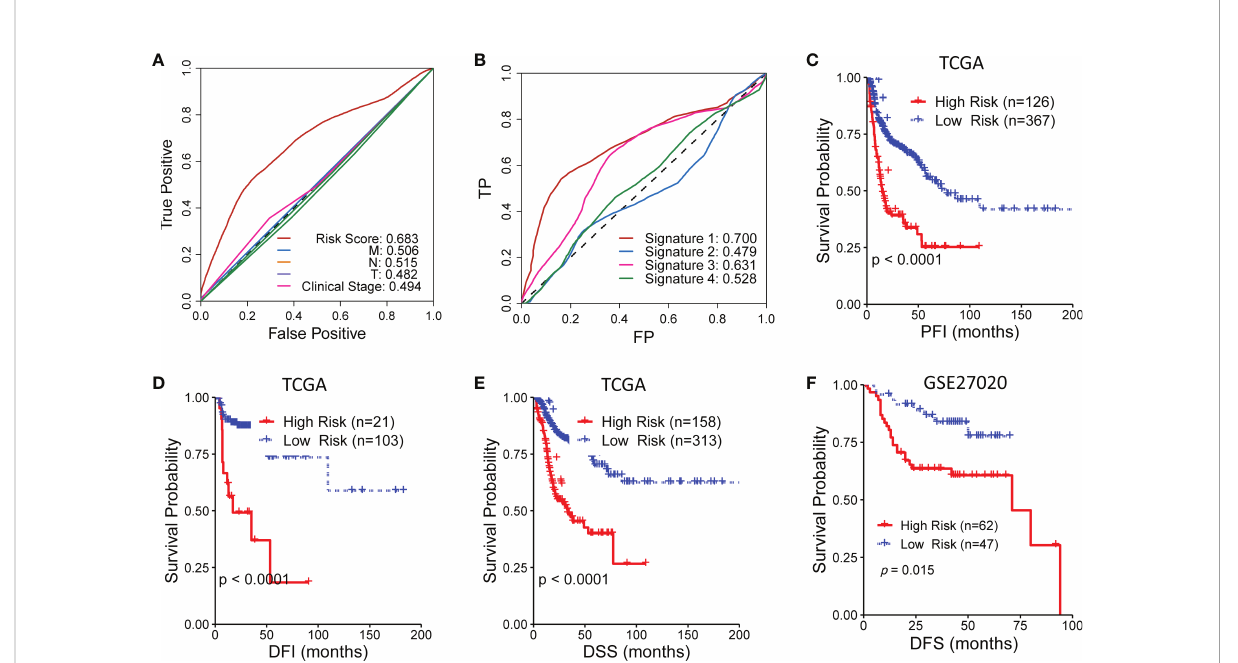
FIGURE 3 Comparison of the circadian rhythm (CR)-related gene signature with other indicators for overall survival in head and neck squamous cell carcinoma. (A) The CR-related gene signature showed an improved predictive performance compared with clinical T staging, clinical N staging, clinical M staging, and clinical stage. (B) The CR-related gene signature (Signature 1) also showed an improved predictive performance compared with the three reported gene signatures, namely, an immune-related gene signature (5) (Signature 2), an eight-gene signature (4) (Signature 3), and an autophagy-related gene signature (3) (Signature 4). (C – E) The low-risk group had a signi fi cantly improved progression-free interval, disease-free interval, and disease-speci fi c survival compared with the high-risk group in The Cancer Genome Atlas. (F) The low-risk group had a signi fi cantly improved disease-free survival compared with the high-risk group in